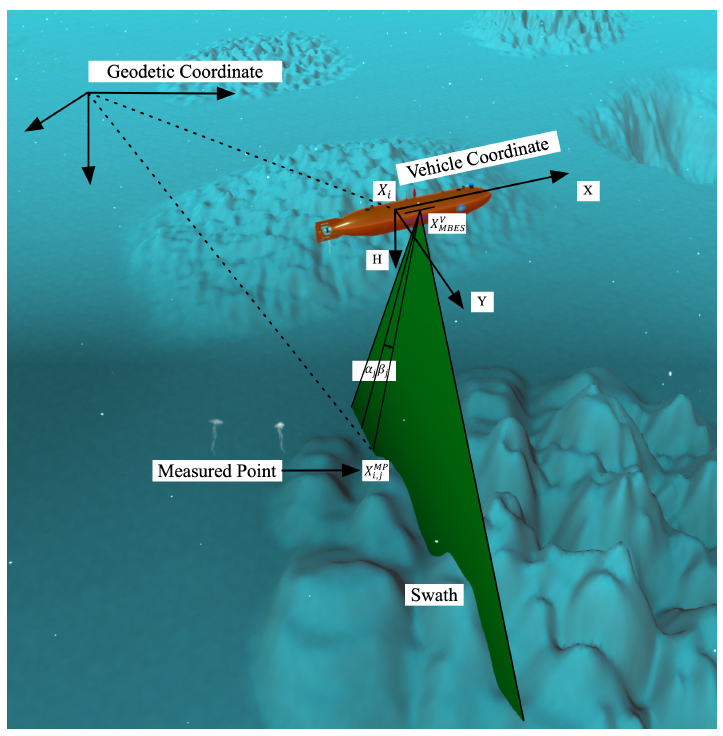
Figure 2. System specification for an AUV to acquire a bathymetry